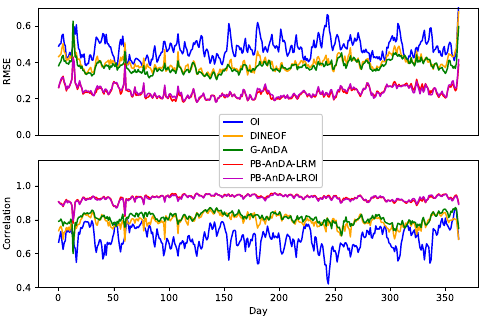
Figure 5. Mean RMSE and correlation time series for MW SST case-study: OI (blue), DINEOF (orange), G-AnDA (green), PB-MS-AnDA-LROI (red), PB-MS-AnDA-LRM (purple) methods.